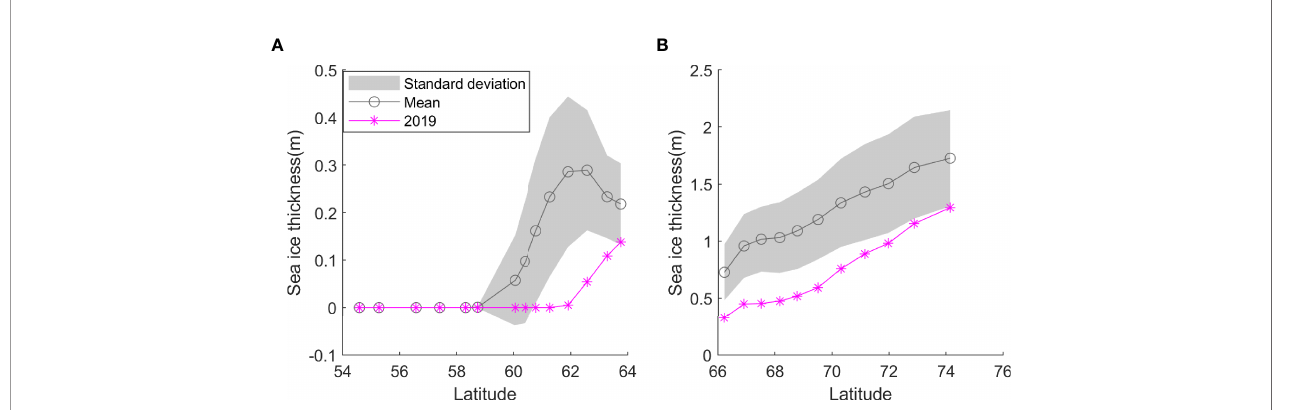
FIGURE 8 | The monthly mean sea ice thickness from January to August. (A) BL section. (B)